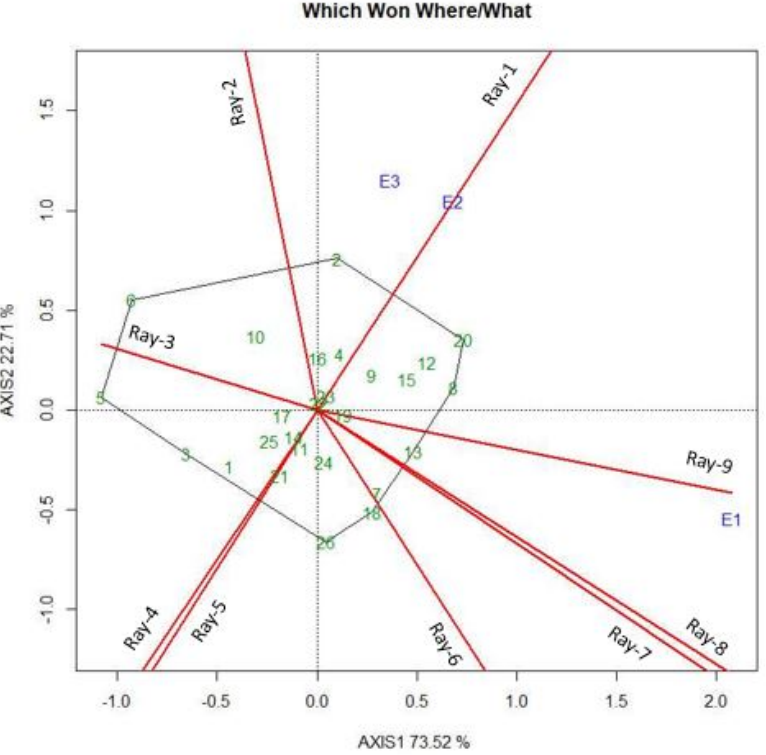
Figure 4. The polygon (mega-environment) view of the GGE biplot of 26 rice hybrid combinations was tested in three locations for grain